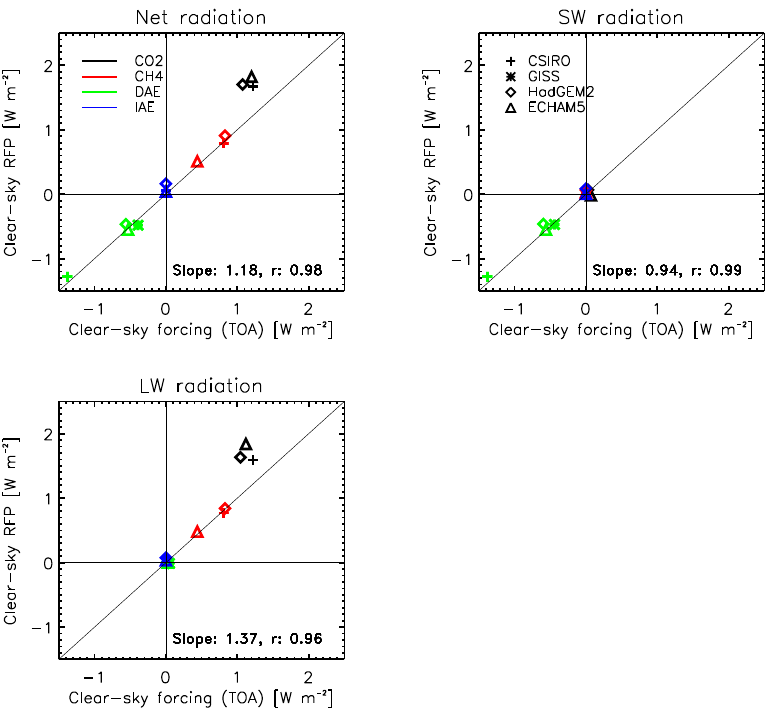
Fig. 3. As Fig. 2, but for the clear-sky net, shortwave and longwave RFP versus TOA F from four GCMs.